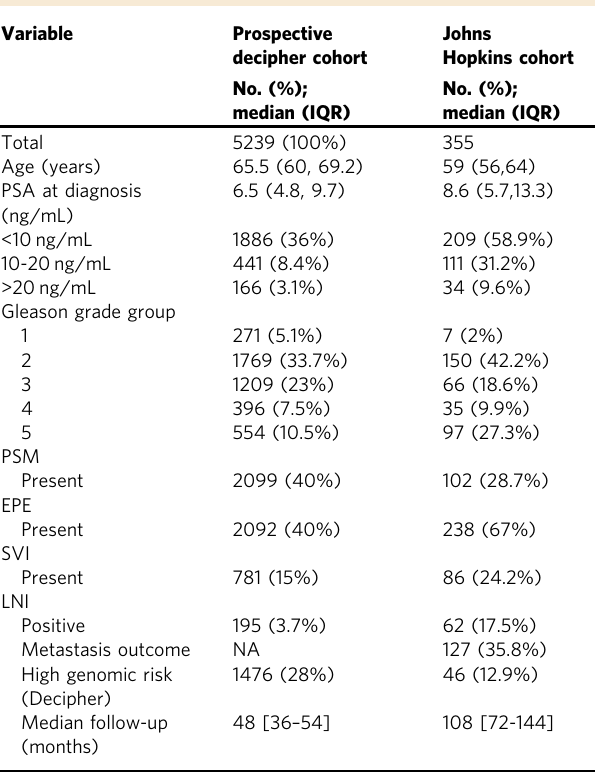
Table 2 Clinical characteristics for decipher and JHMI patient